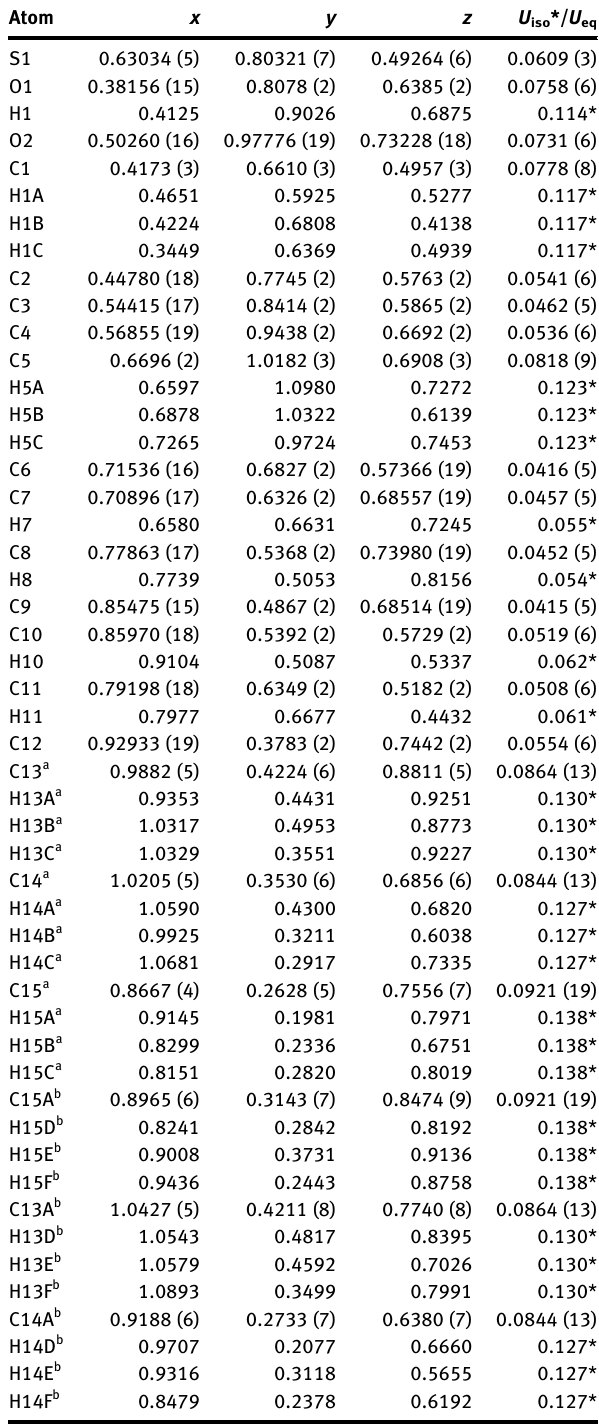
Table  : Fractional atomic coordinates and isotropic or equivalent isotropic displacement parameters (Å 